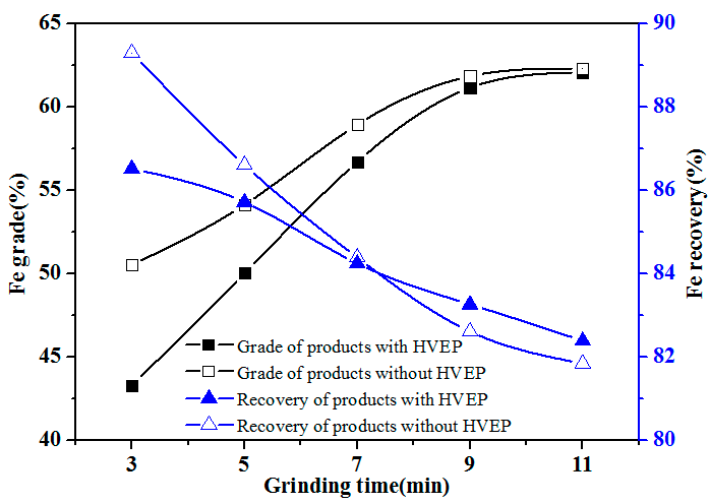
Figure 9. Magnetic separation results of samples treated and untreated with HVEP treatment.